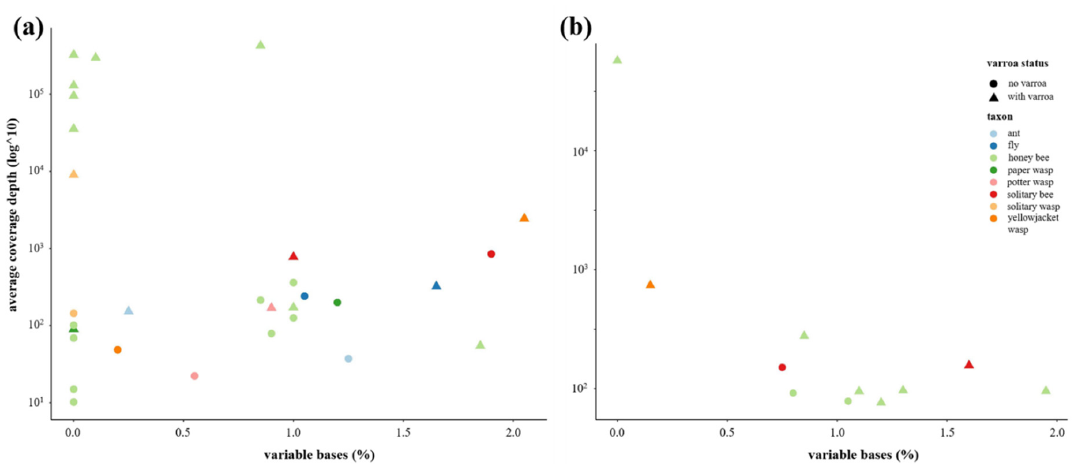
Figure 6. DWV diversity as represented by the proportion of variable base positions (%) between 7000–9000 bp on the reference genomes, as a function of average read depth across the same fragment for ( a ) DWV-A; and ( b ) DWV-B.